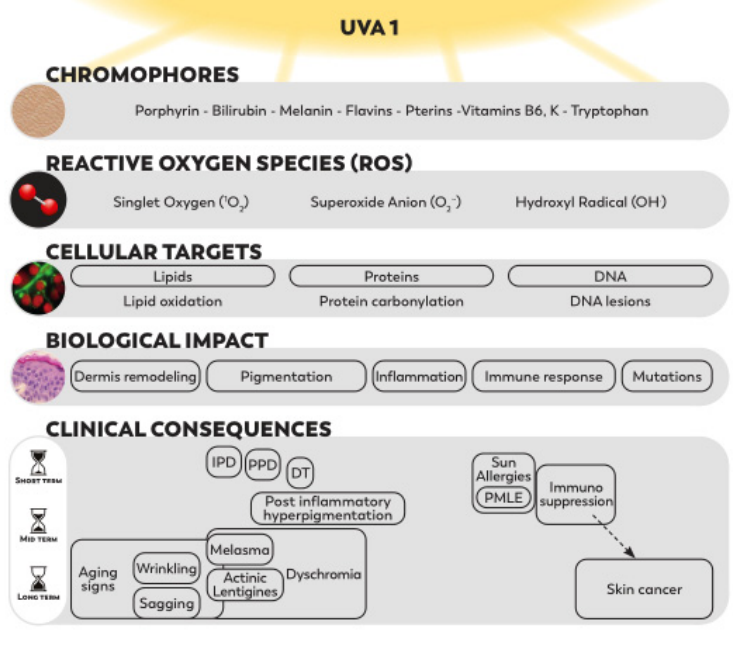
Figure 6. Schematic representation of UVA1 impacts on skin. The described effects of UVA1 exposure on skin are schematically represented, starting from the initial events with the absorption of UVA1 by chromophores and the generation of ROS to the biological and clinical consequences ranging from short-term to long-term effects. The dotted line indicates that photoimmunosuppression can contribute to skin cancer development.